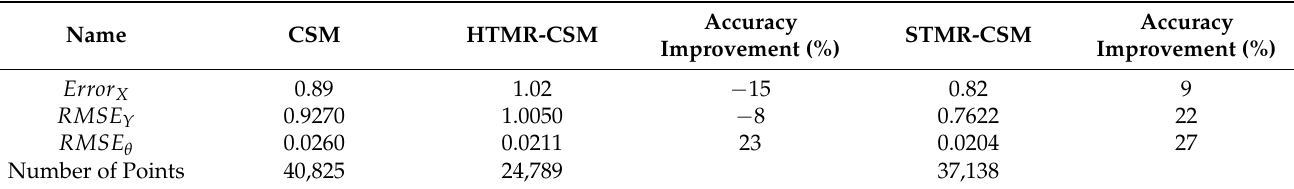
Table 2. Location Error and Number of